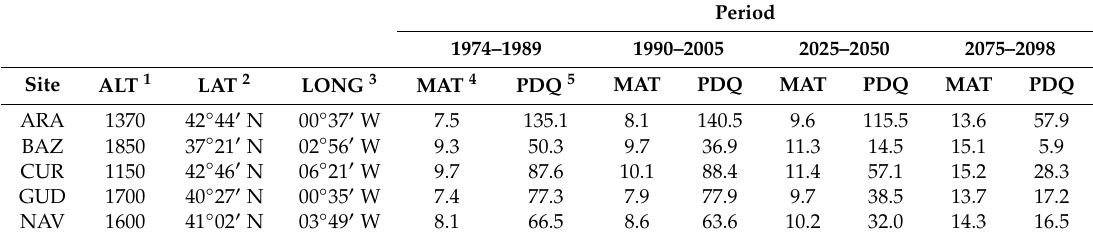
Table 1. Location and two climatic indices of the sites for di ff erent periods (see Appendix A for details).